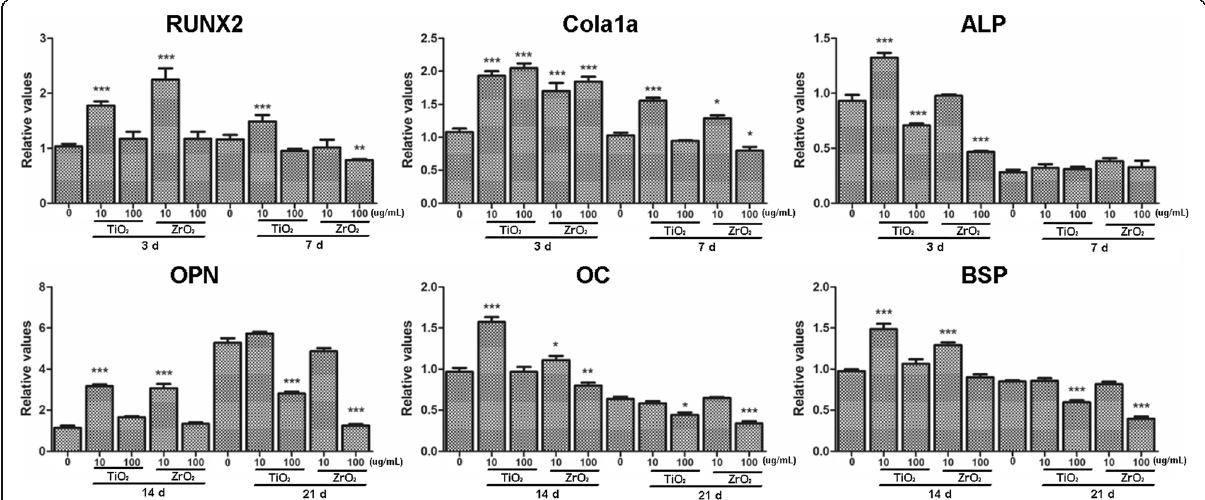
Fig. 8 TiO 2 and ZrO 2 NP-induced osteogenesis-related genes changes in 3T3 cells. After the 3T3-E1 cells were differentiated using mineralized solution for 3, 7, 14, and 21 d, accompanied with TiO 2 and ZrO 2 NPs at various concentrations. The osteogenesis-related gene changes were detected using RT-PCR. The results represent the means ± SEM of three independent experiments. * p < 0.05; ** p < 0.01; *** p < 0.001, compared with the